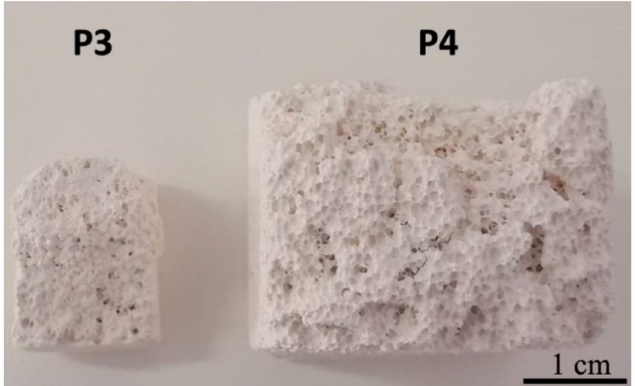
Figure 1. General overview of the ceramic scaffolds P3 and P4. Scale bar represents 1